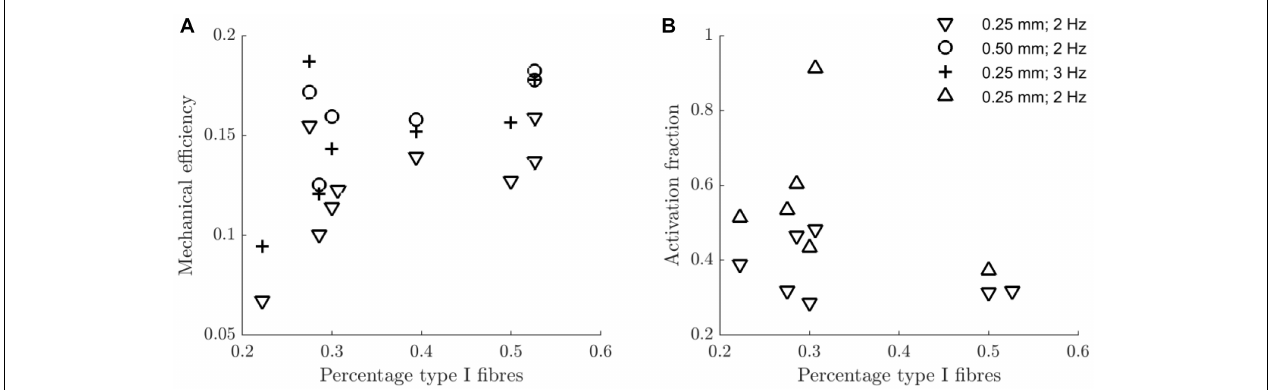
FIGURE 7 | Scatterplot of the mechanical efficiency (A) and the fraction of metabolic energy spent on the activation process (B) against the percentage of type I fibers, for each contraction condition. The legend in panel (B) indicates the contraction conditions (amplitude and movement frequency), and serves both panels. The downward pointing triangles refer to concentric contraction and the upward pointing triangles refer to eccentric contraction. For each condition and variable, the Spearman correlation with the percentage of type I fibers is listed in Table 5 . TABLE 5 | Spearman’s correlation coefficients and p -values of associations between the fraction of metabolic energy spent on activation/the mechanical efficiency, and the percentage of type 1 fibers. Variable/condition Spearman’s rho p -value Number of observations Activation fraction, concentric − 0 . 43 0.354 7 0.497